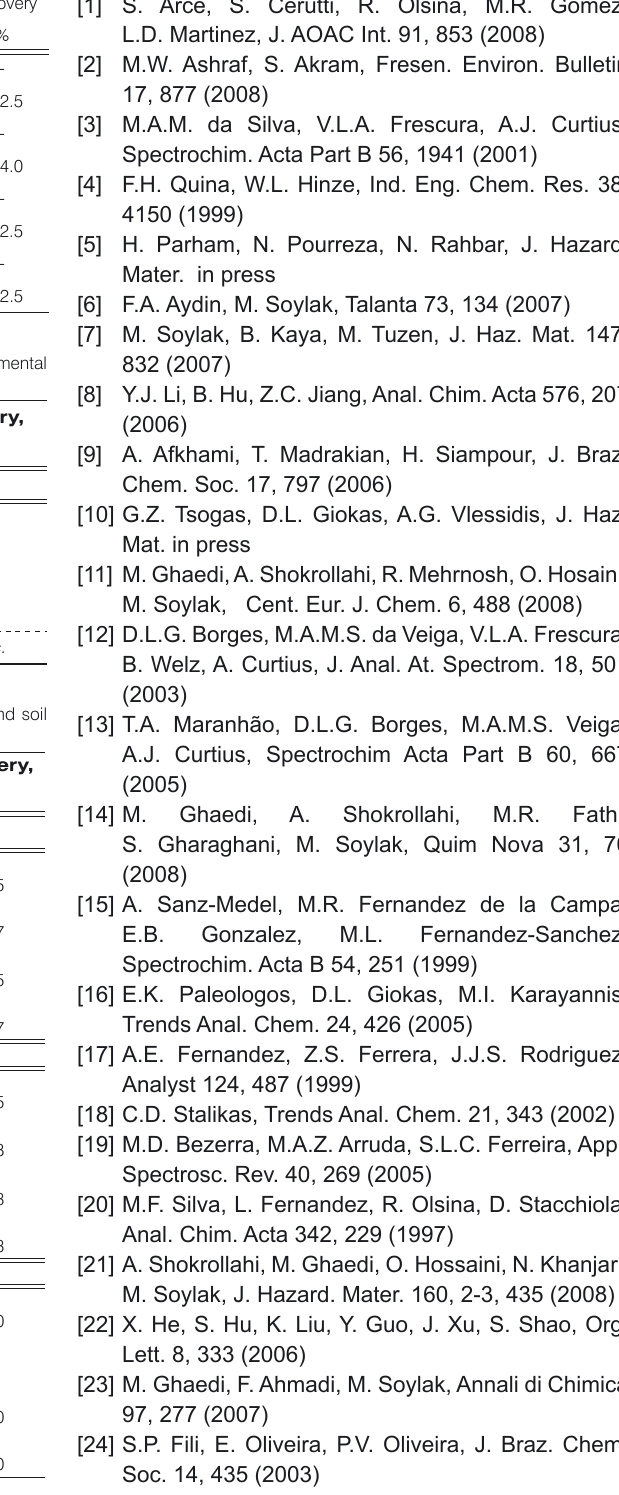
Table 2. Recovery of trace elements from spiked blood and lotus samples after application of presented procedure, samples (N = 3) Ion Blood Lotus tree Added Found RSD Recovery Found RSD Recovery μg g -1